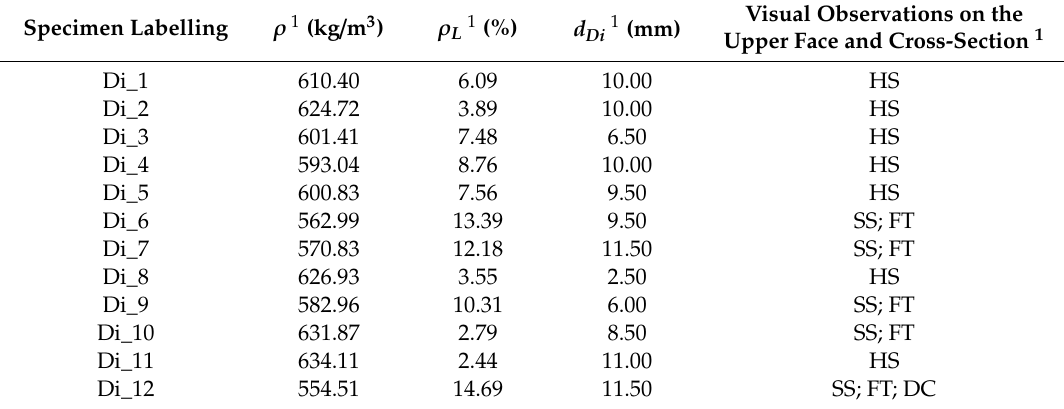
Table 1. Density loss as per physical aspects and damage features of anobiid-deteriorated wood.